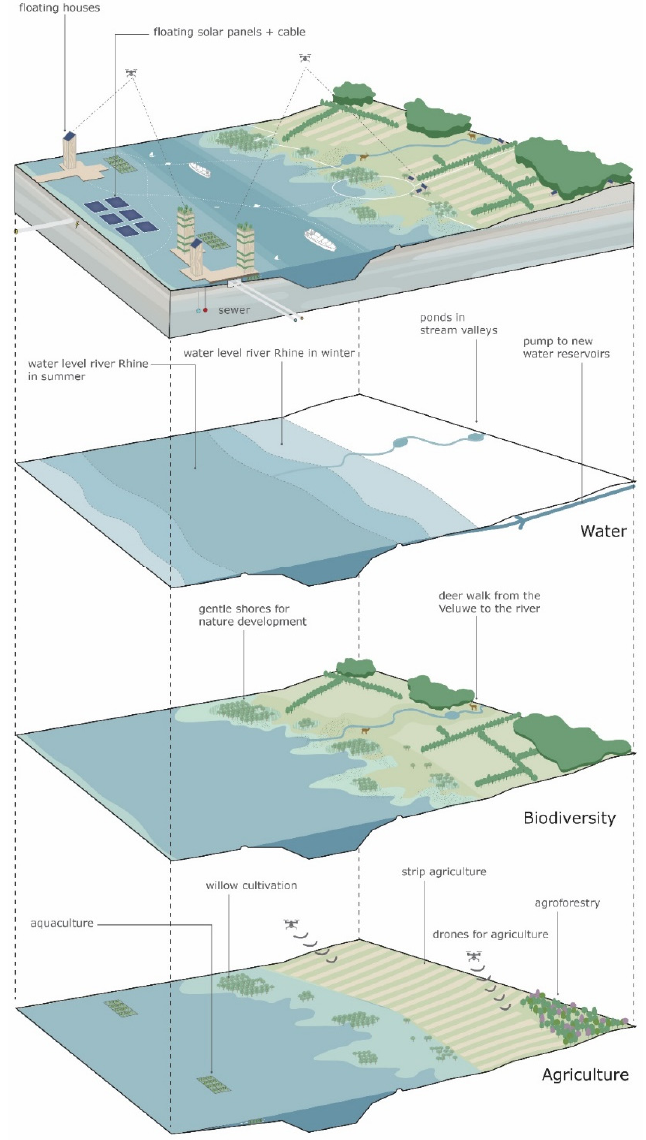
Figure 4. Exploded axonometric view of the river area (Arnhem case) that illustrates the integrated nature of the proposed solutions (source: [42]).